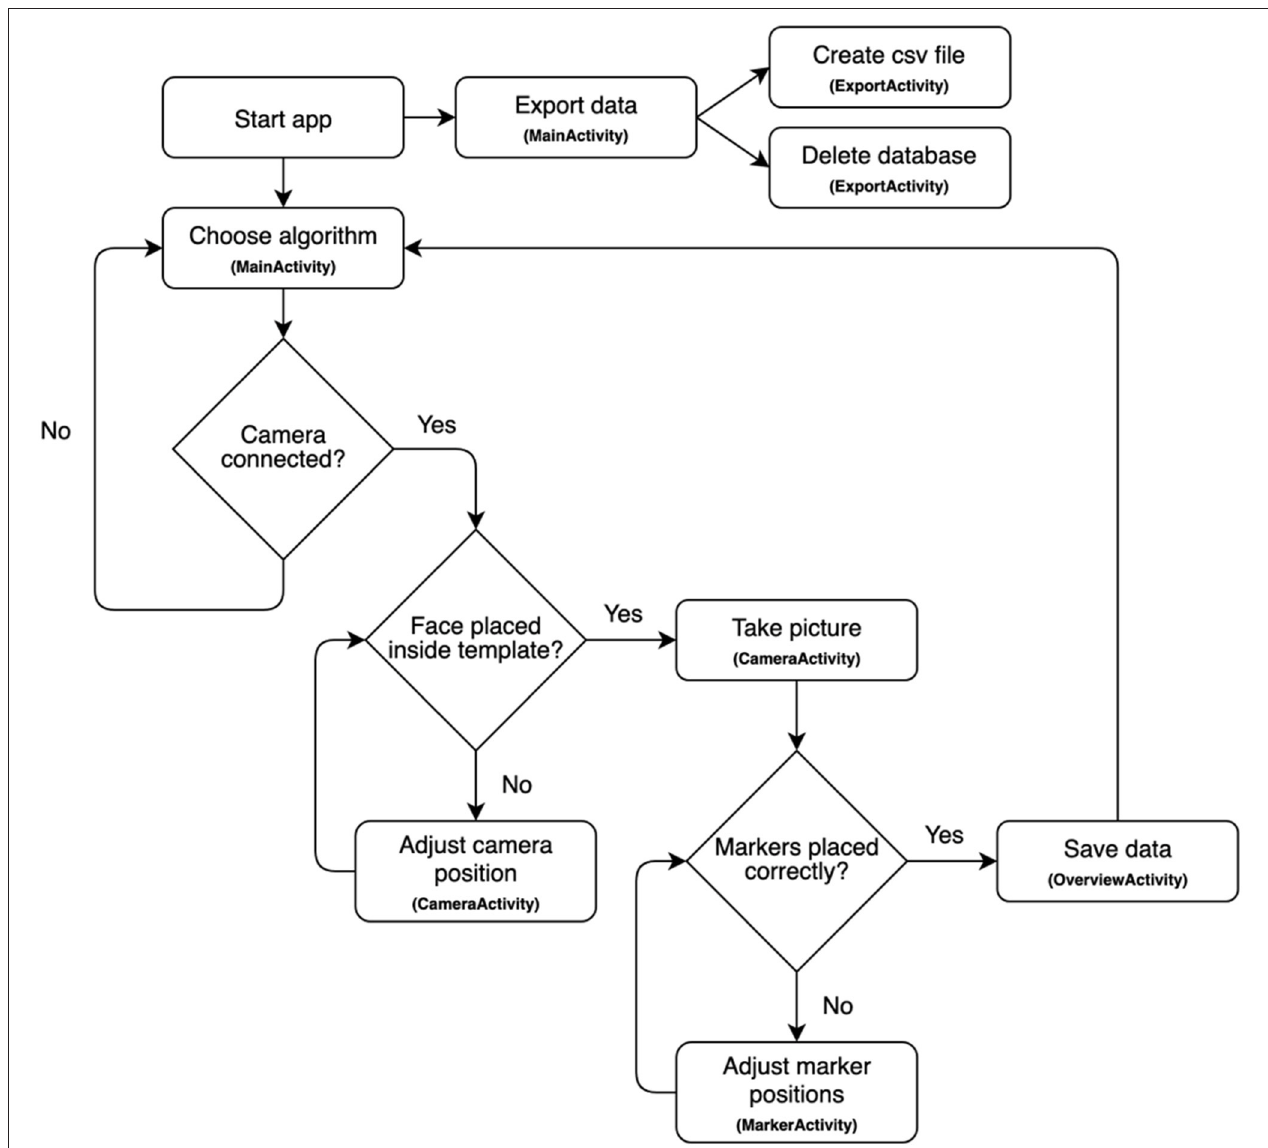
FIGURE 8 | Flow chart overview of the android